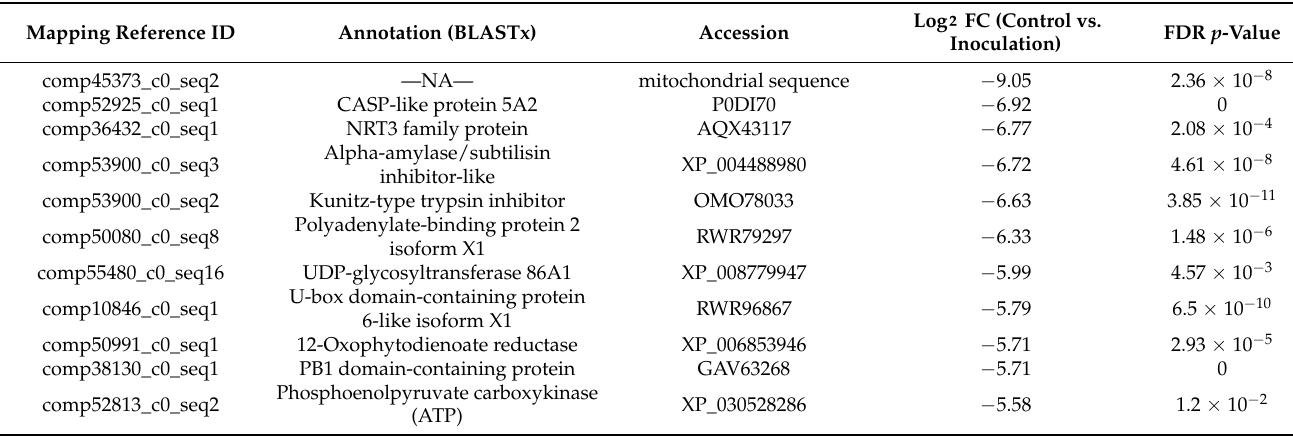
Table 3. Eleven (10 annotated) most upregulated transcripts after inoculation (compared to control).